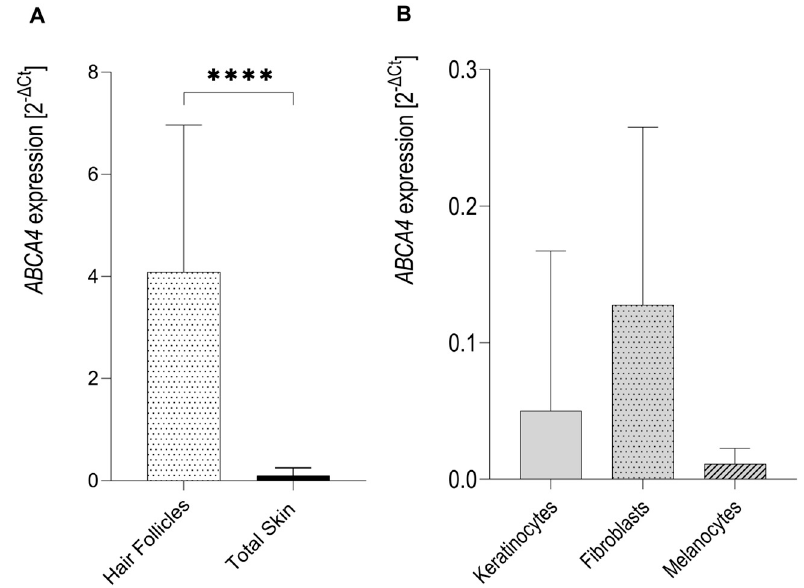
Figure 1. Expression of the ABCA4 mRNA in hair follicles, skin lysates, as well as keratinocytes, dermal fibroblasts and melanocytes as measured by qRT-PCR for TaqMan probe Hs00979586_m1 ( ABCA4 exons 35–36). ( A ) Expression of the ABCA4 gene in the isolated hair follicles was significantly higher than in total skin lysates. ( B ) Relatively very low expression of the ABCA4 gene was detected in fibroblasts, keratinocytes and melanocytes. ∗∗∗∗ p < 0.0001 as calculated by Mann-Whitney U test.